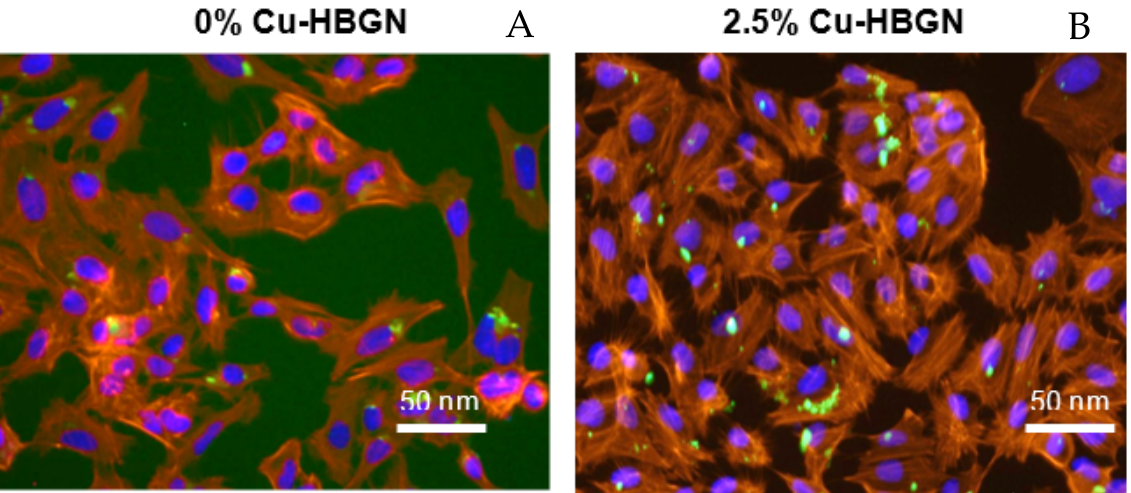
Figure 6. Representative images of 0% ( A ) and 2.5% Cu-HBGN ( B ) internalized inside MC3T3-E1 cells. The cytoskeleton of the cells is seen in red, the cell nucleus in blue and the FTIC-labelled HBGN in green.